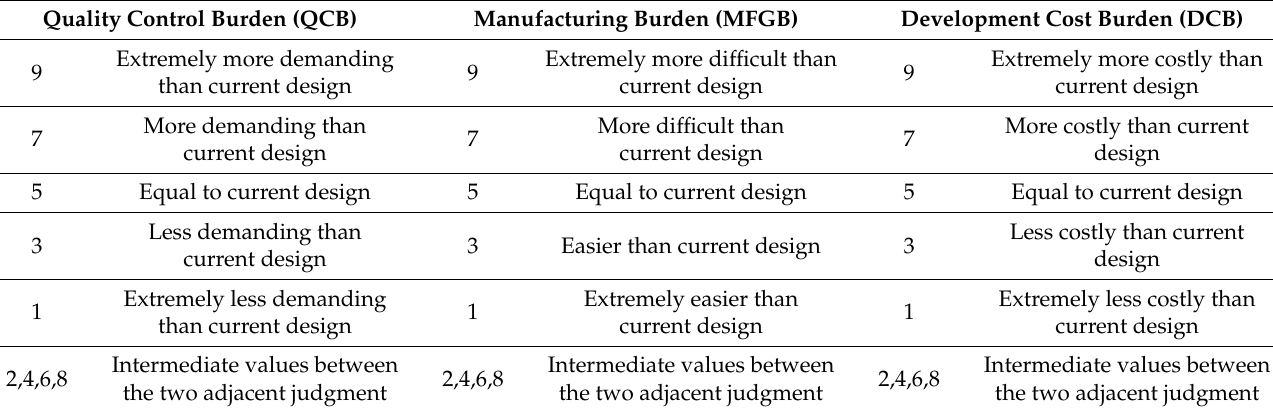
Table 4. Nine-point scales to assess the inputs to design development